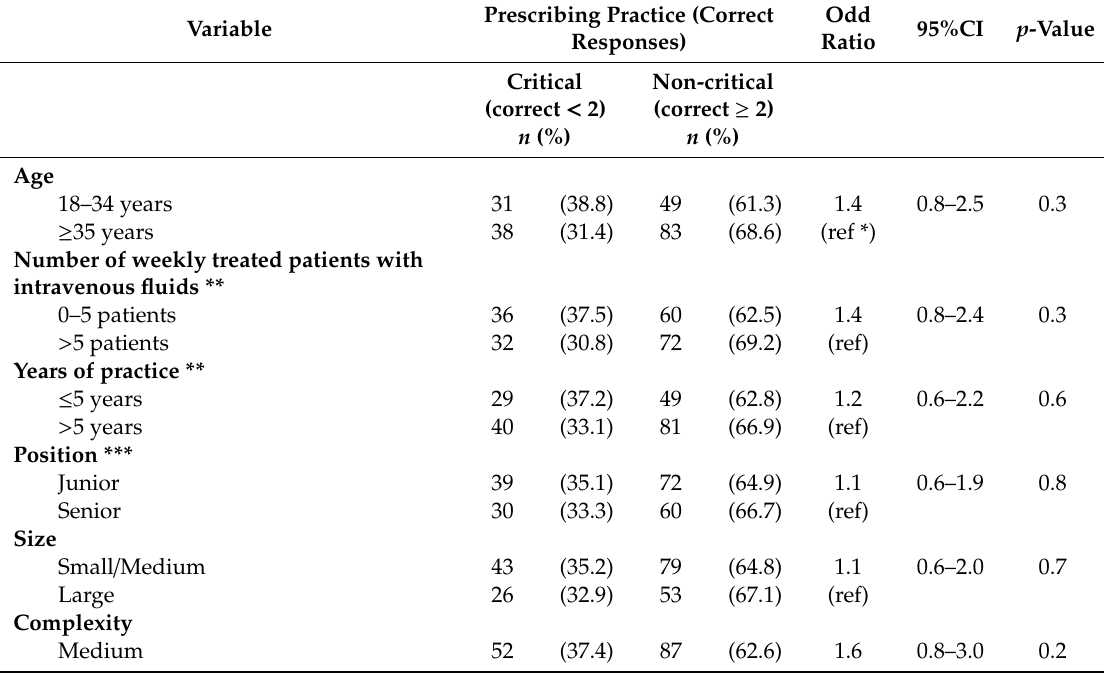
Table 5. Critical prescribing practice, demographics, and characteristics of emergency departments (EDs) by simple logistic regression conducted separately for each individual